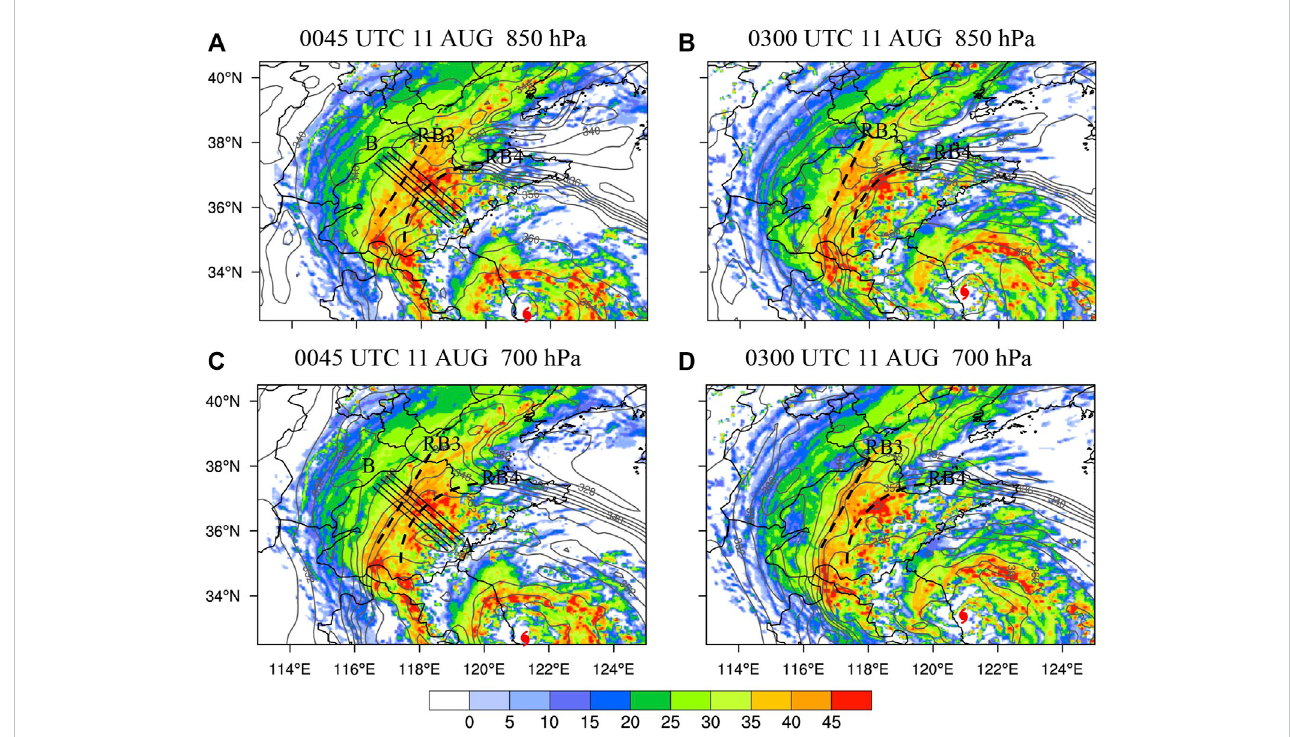
FIGURE 10 Composite re fl ectivity (shaded; unit: dBZ) and 850-hPa equivalent potential temperature (contours; unit: K) from the D02 simulation at (A) 0045 UTC 11August; (B) 0300UTC11August2019. (C) and (D) asin (A) and (B) butat700 hPa.Blacksolidlinesindicatethepositionsoftheverticalcrosssectionstakenin Figure 11, black dashed lines indicate the positions of the rainbands, and typhoon symbols denote the locations of Lekima ’ s center.